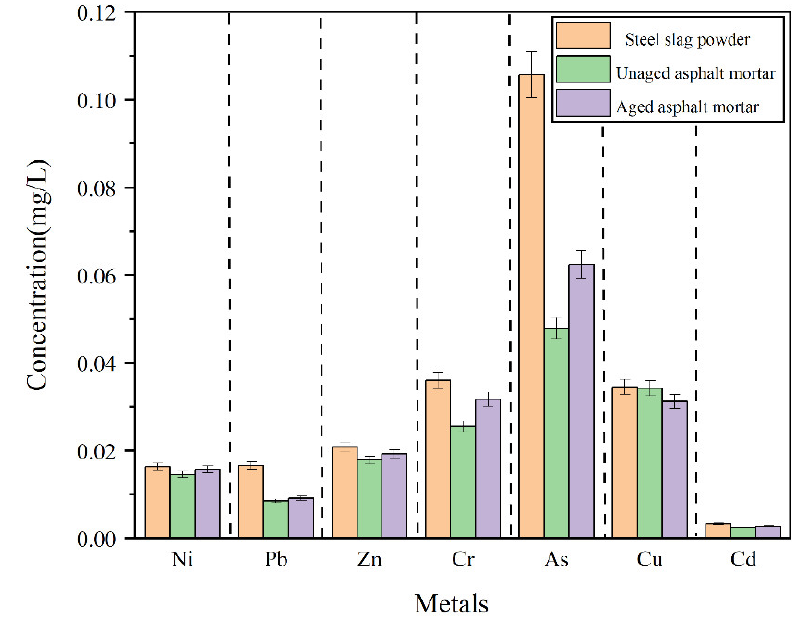
Figure 13. Heavy-metal leaching from asphalt mortar.